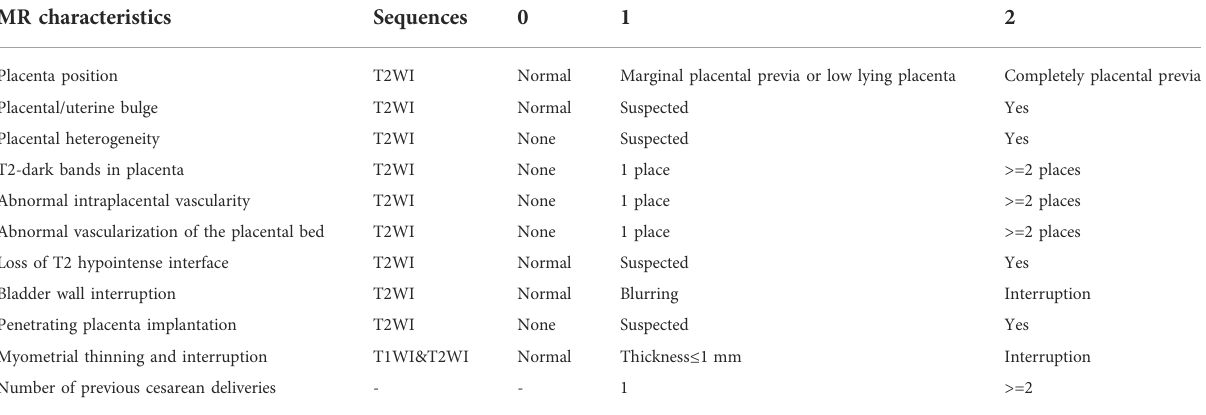
TABLE 1 Magnetic resonance imaging-based scoring system for pernicious placenta